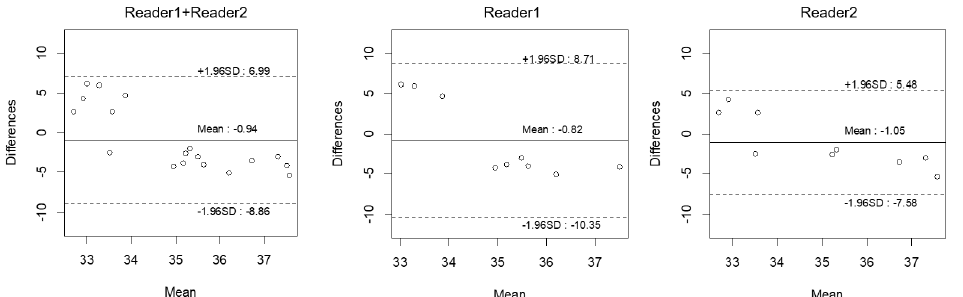
Figure 4. Bland–Altman plots of equivalent T2* values and measured T2* values at